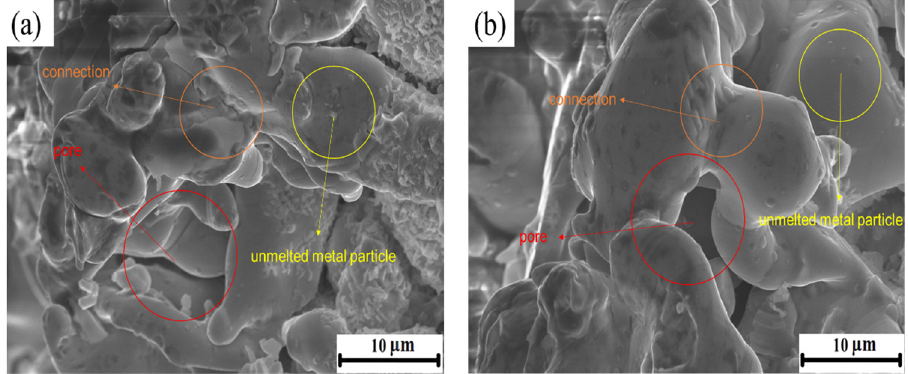
Figure 3: The wall SEM of the MHSs sintered at 1,100°C: ( a ) 2.88 mm and ( b ) 5.76